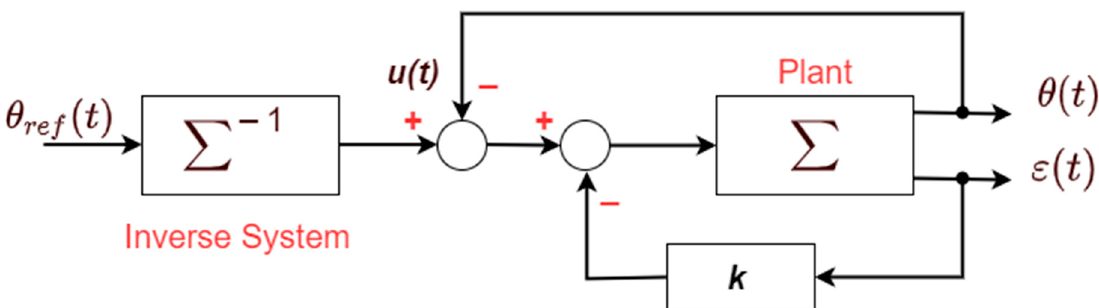
Figure 7. Two-degrees-of-freedom inversion system generated by system identification.